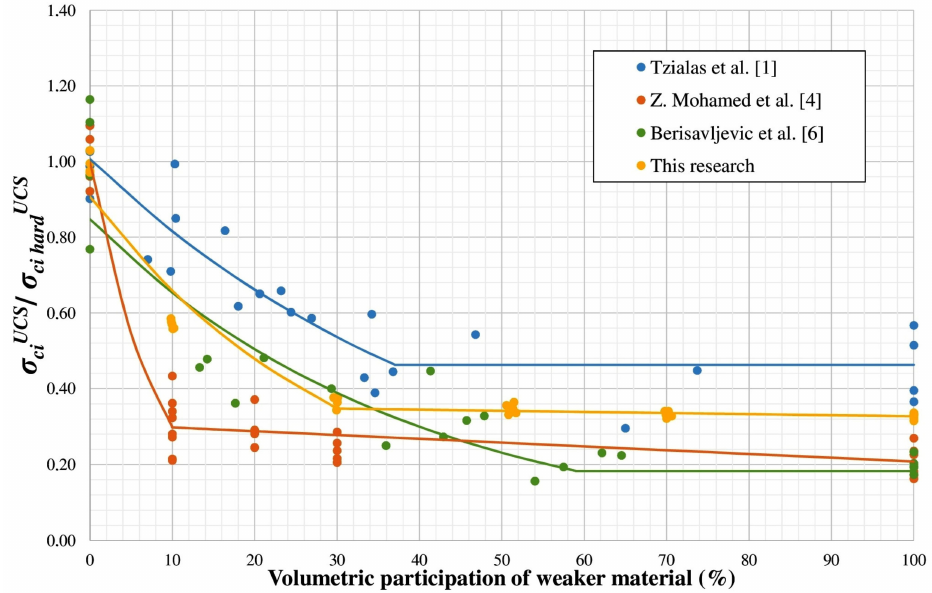
Figure 15. Comparison of the results σ ciUCS / σ ci hardUCS with others